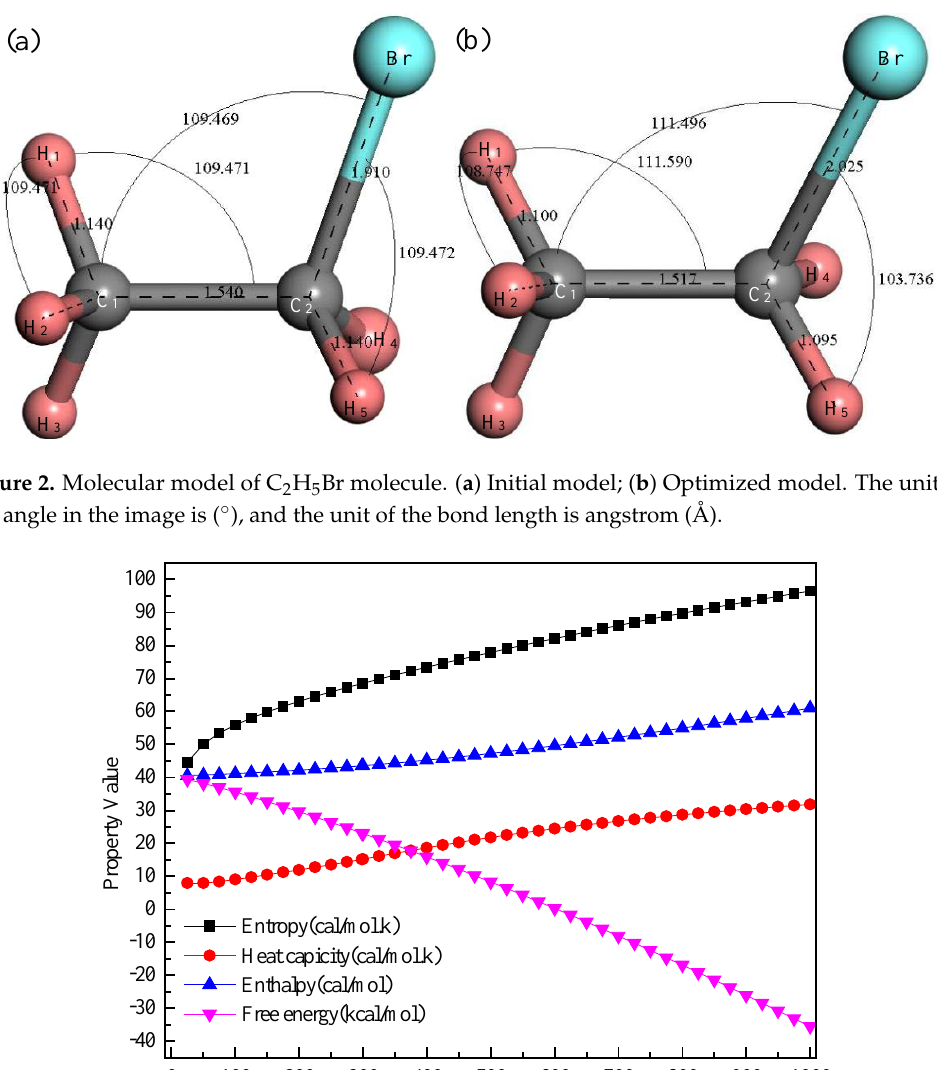
Figure 1. Scanning electron microscopy ( SEM) image and energy dispersive spectrometer (EDS) analysis of Graphene/aluminum composites with different reaction times: ( a ) Graphene/aluminum composites prepared with reaction time of 1 h; ( b ) Graphene/aluminum composites prepared with reaction time of 1.5 h; ( c ) Low-magnification SEM image of composite prepared with reaction time of 1.5 h; ( d ) map analysis of ( c ).